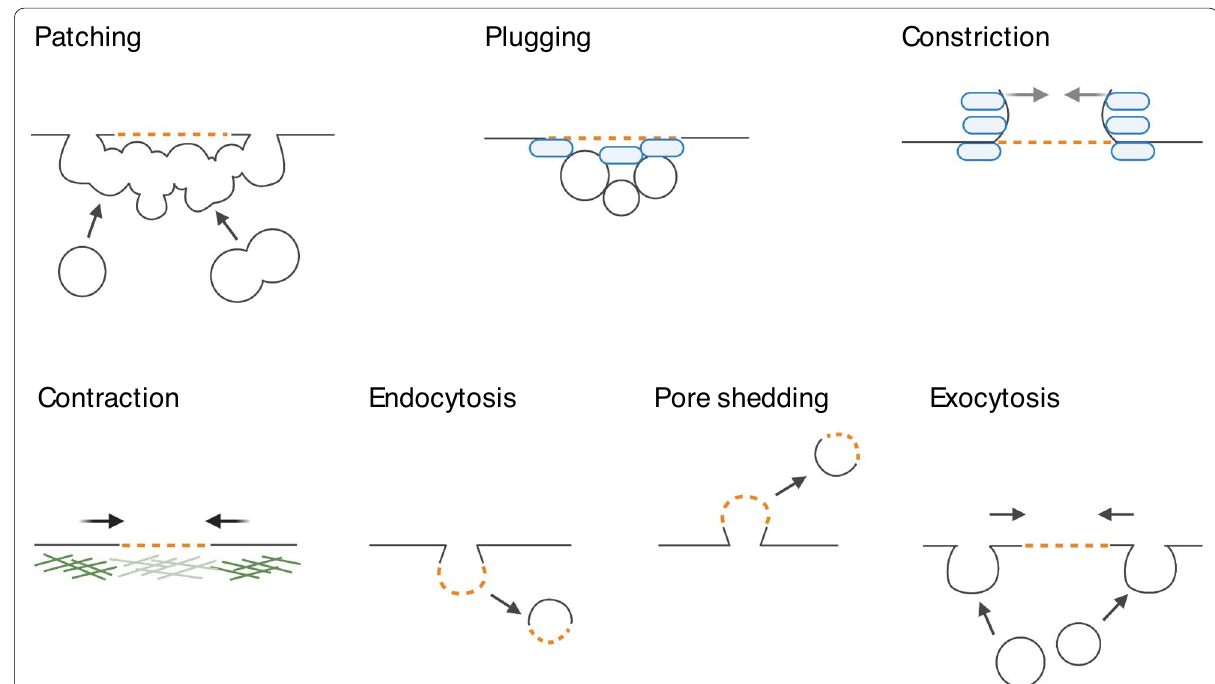
Fig. 2 Several mutually non-exclusive mechanisms contribute to plasma membrane repair. Orange dotted lines indicate a breach in the plasma membrane. Annexins are represented in blue and the actin cortex in